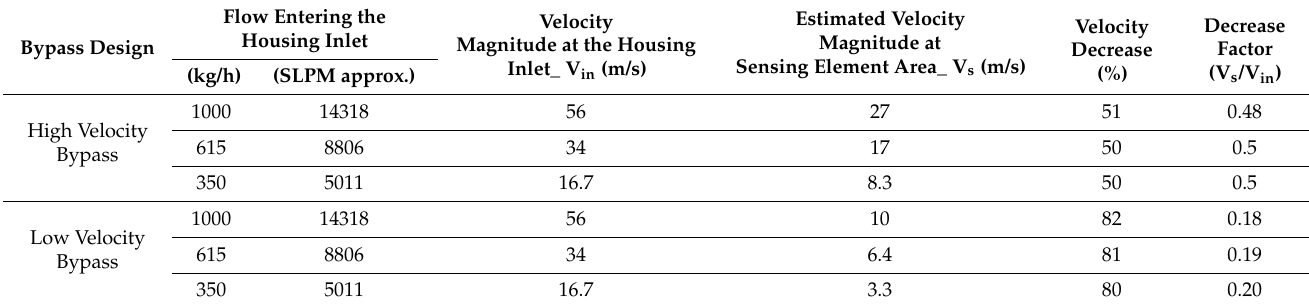
Table 2. Design geometry simulation results, velocity reduction at sensing element area.